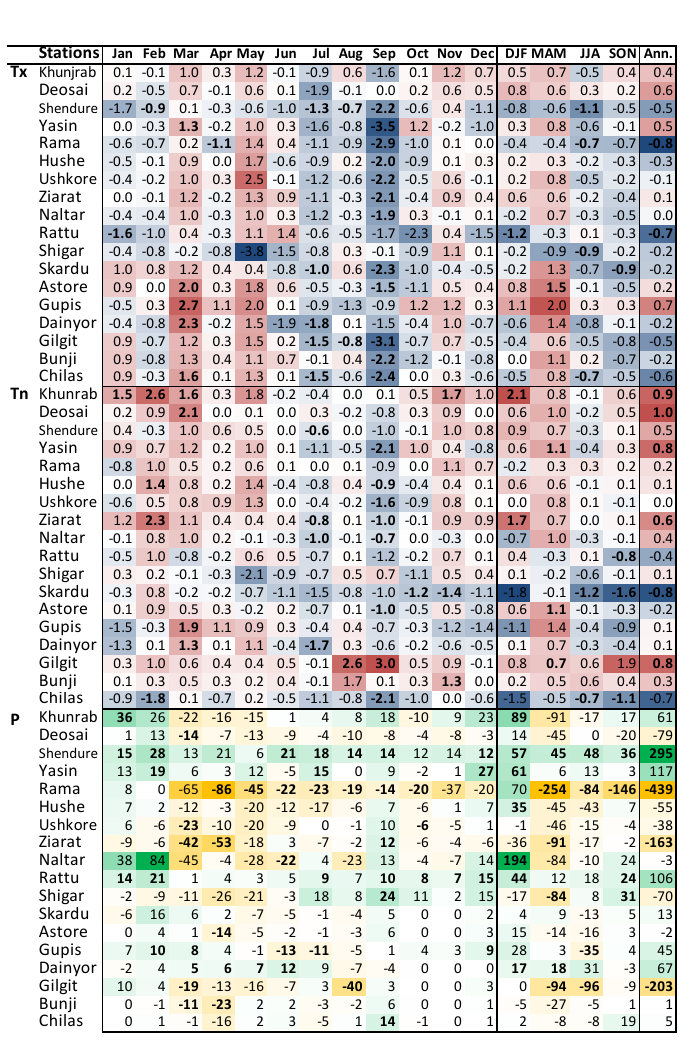
Figure 4. Decadal trends in maximum (Tx), minimum (Tn) temperatures ( ◦ C) and precipitation (P in mm). Trends significant at 90% level are given in bold. Negative signs and blue/yellow colors indicate decrease while non-negative values and red/green colors indicate increase. Note: After